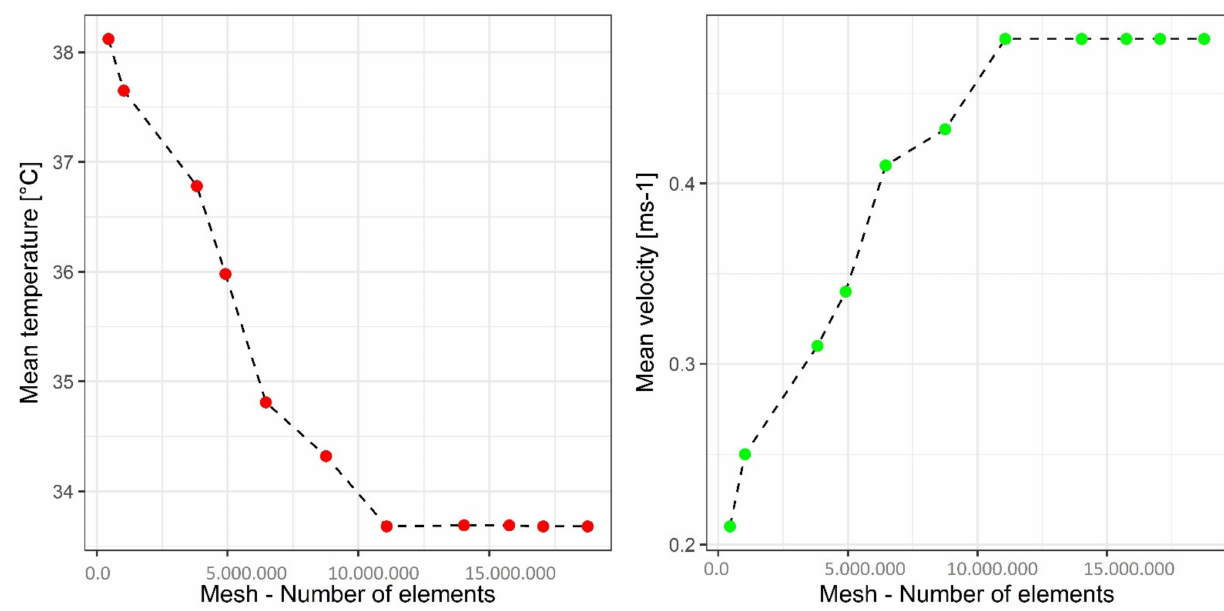
Figure 4. Results of the numerical grid independence test.